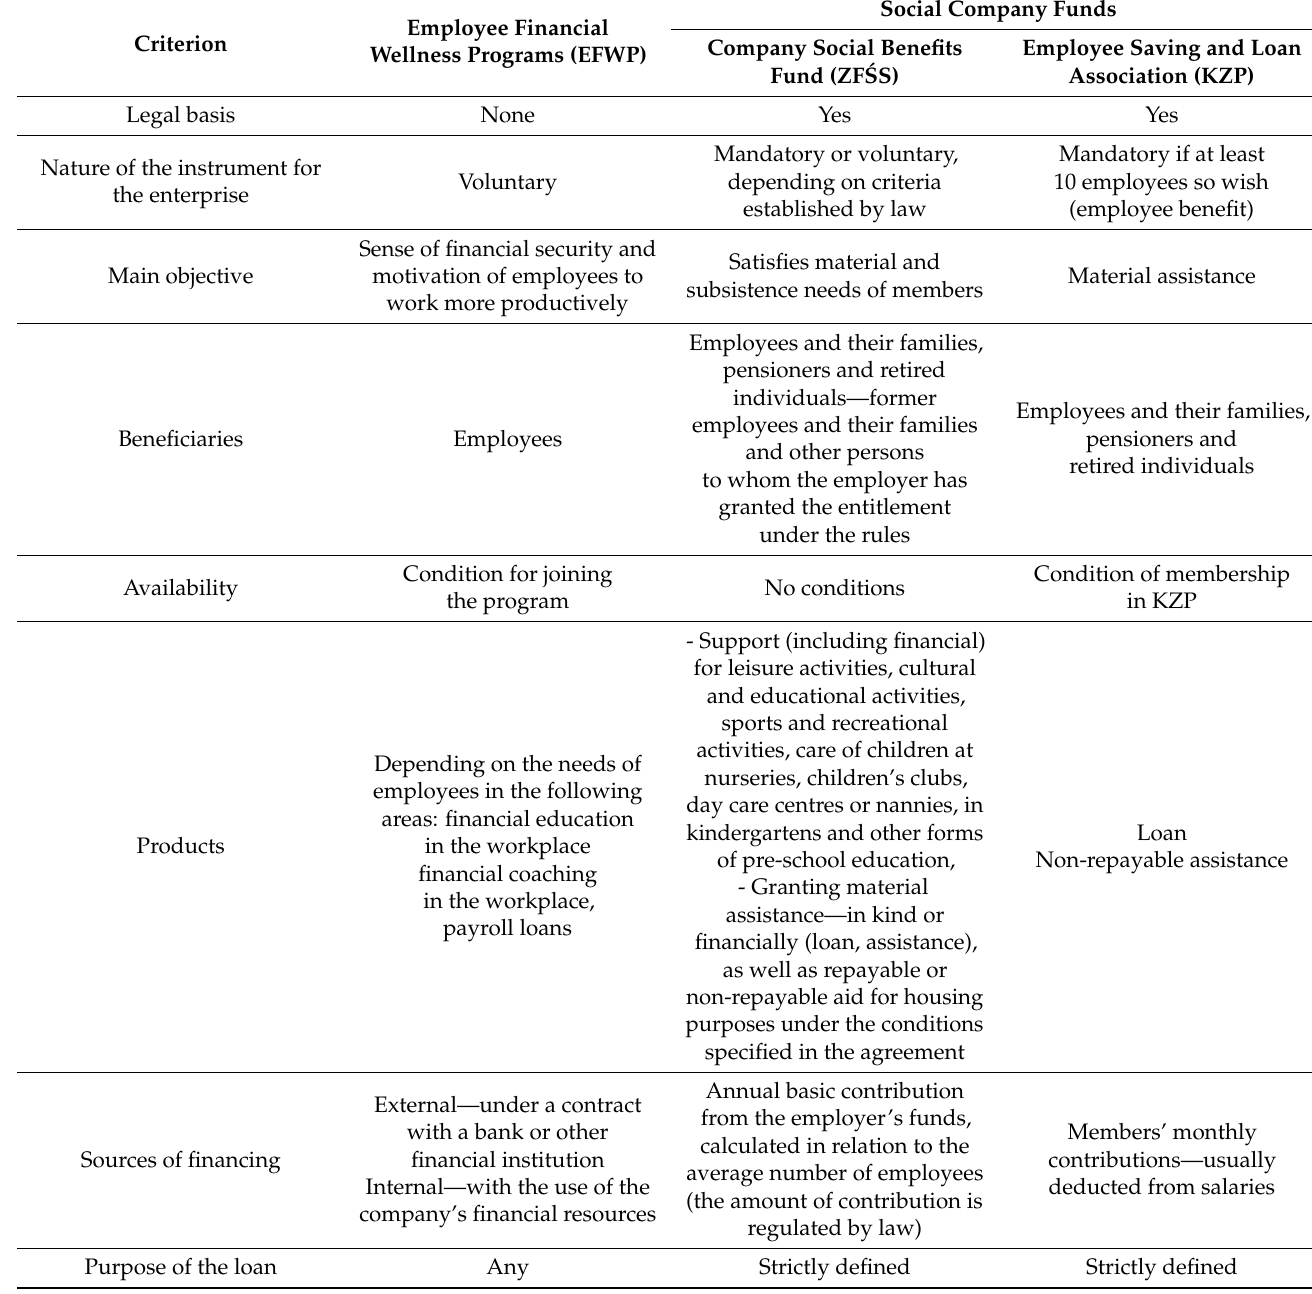
Table 3. Summary of differences between Employee Financial Wellness Programs and solutions applied by enterprises in Poland within social